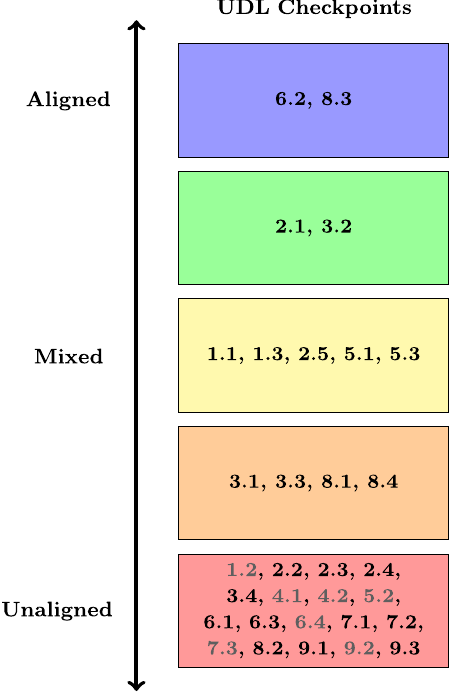
FIG. 1. Ranking of the alignment between the UDL check- points and the four selected physics curricula overall. Gray shading indicates unalignments due to implementation variability and